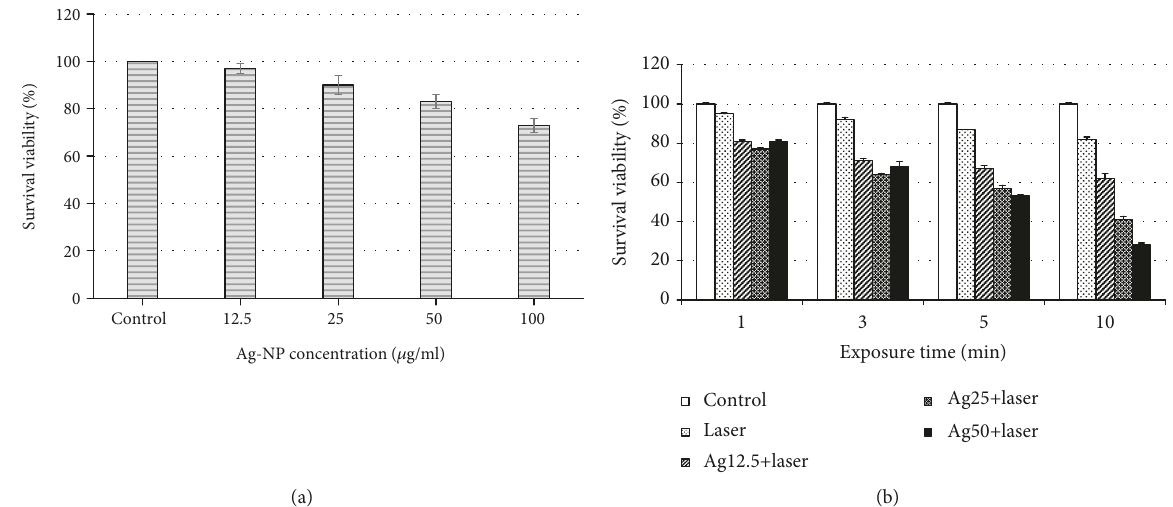
Figure 5: (a) E ff ect of Ag-NPs on the survival of S. aureus for di ff erent concentrations of Ag-NPs (12.5, 25, 50, and 100 μ g/ml) under normal light condition. (b) E ff ect of laser irradiation at 410 nm and photoirradiation of Ag-NPs on the survival of S. aureus for di ff erent exposure times (1, 3, 5, and 10min) and concentrations of Ag-NPs (12.5, 25, and 50 μ